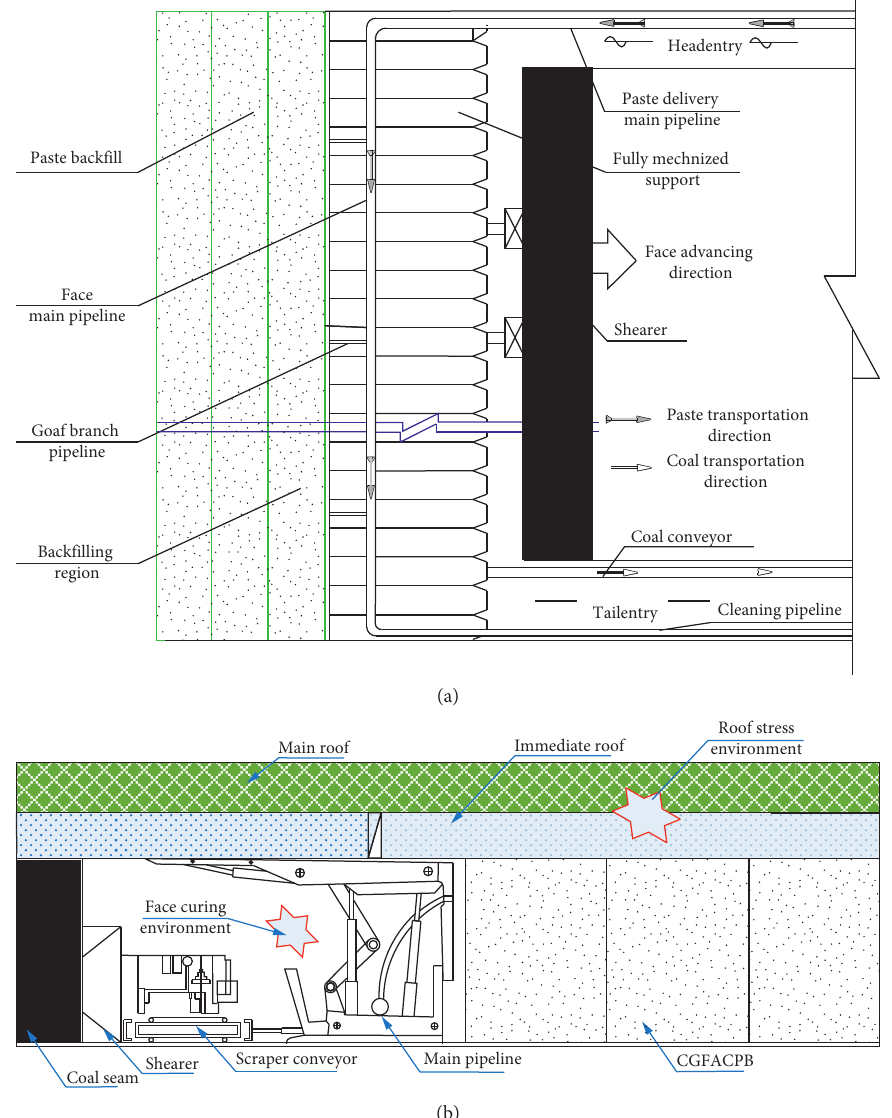
Figure 7: Schematic diagram of longwall backfilling curing and stress environment. (a) Backfilling panel. (b) Cross